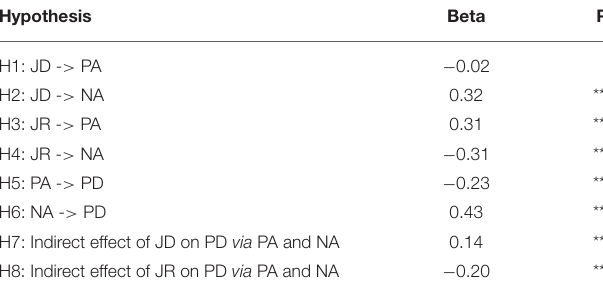
TABLE 3 | Results of hypothesis